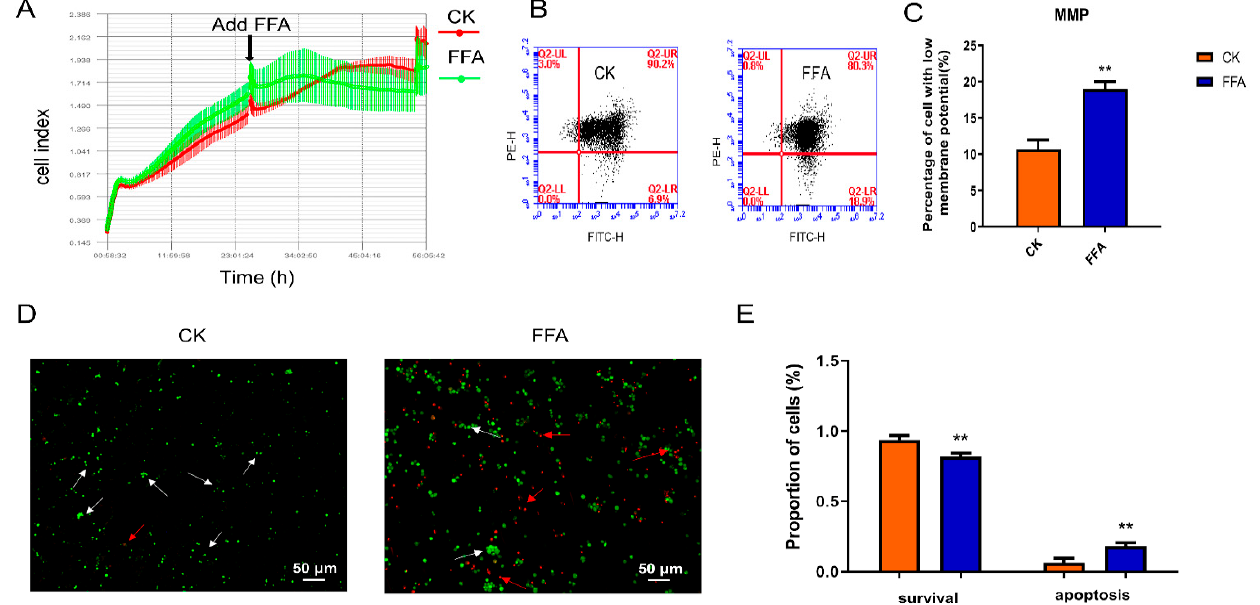
Figure 3. Effect of FFA treatment for 24 h on proliferation and apoptosis of primary hepatocytes in laying hens. ( A ) The cell growth rate was monitored with an iCelligence real-time monitoring system. ( B ) Flow cytometry analysis of MMP. ( C ) The plot of MMP changes. ( D ) AO/EB staining and fluorescence microscopy analysis. ( E ) Data are expressed as the percentage of apoptotic cells in histogram statistics. White arrows point to normal cells and red arrows point to apoptotic cells. Data are shown as the mean ± SD (n = 6), with (**) p < 0.01.